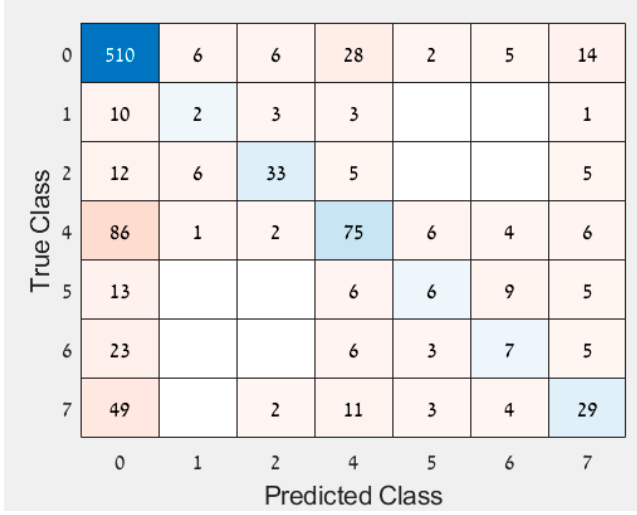
Figure 5. Confusion matrix of ordinal regression. Table 8. Results after balancing healthy and infected samples (Exp1a). Days after Inoculation